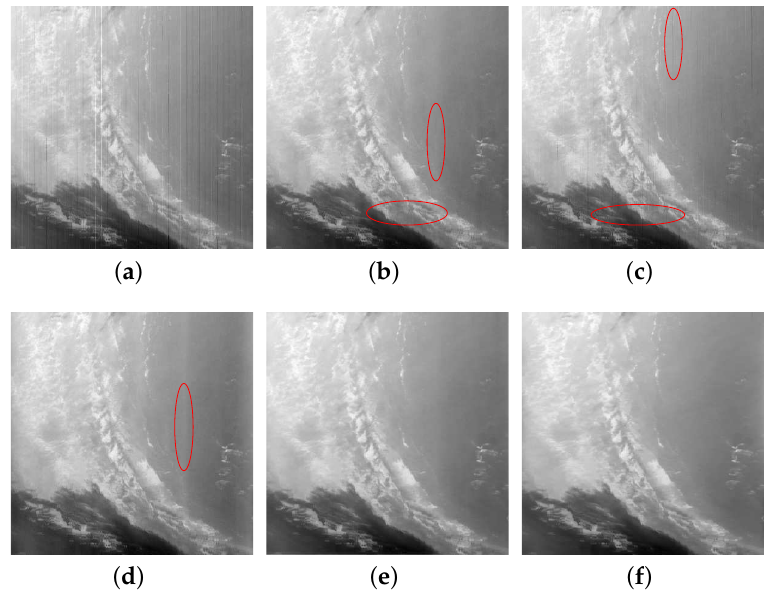
Figure 10. Destriping results of nonperiodic stripes in Terra MODIS band 33. ( a ) Original image;